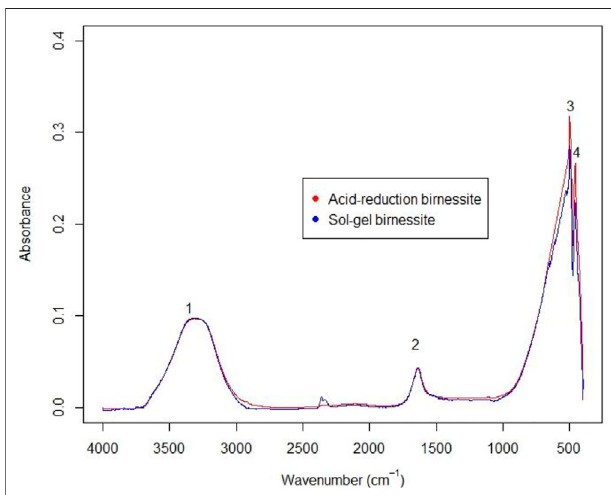
FIGURE 4 | FTIR spectra for the two birnessites used in the experiment.